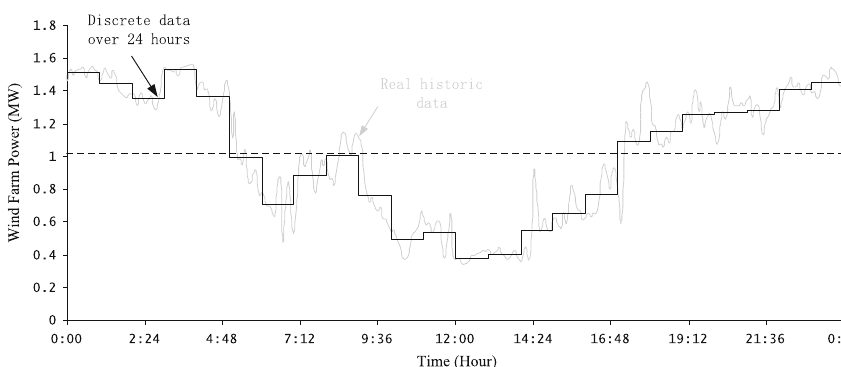
Fig. 6 Daily output power of 1.5 MW DFIG